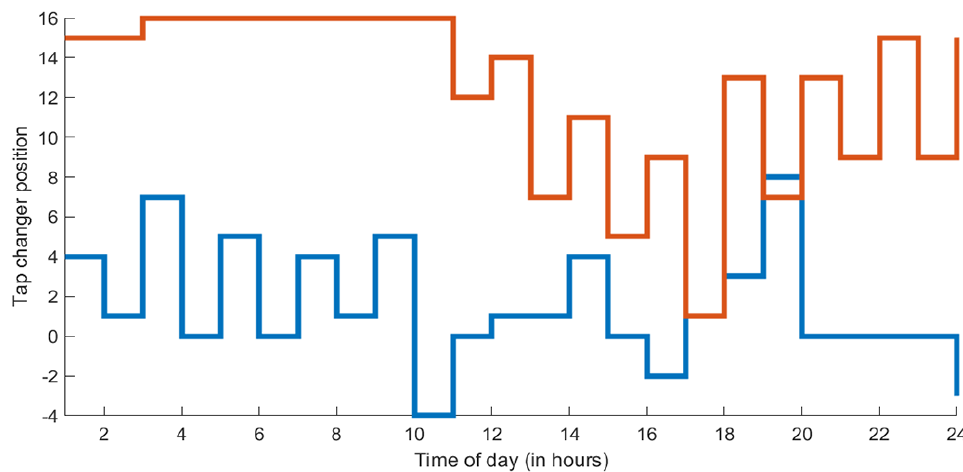
Figure 9. Tap changer settings for 24 h.